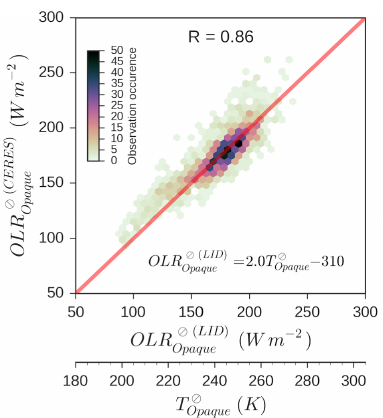
Figure E4. As Fig. E3e but with multilayer cloud considered in the computation of T optically opaque cloud (below) have an equivalent emissivity ε above = 0 . 3: T T | topbelow + T | | T | topabove + T | | Z baseabove opaque = and T above 2 2